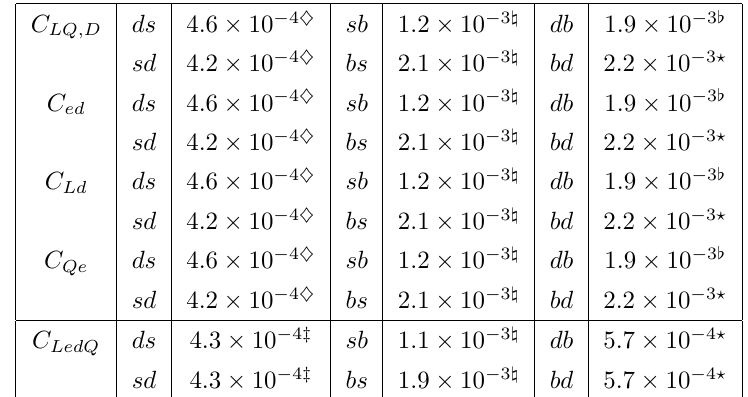
Table 13 . 90% C.L. upper limits on the down-type quark-flavor-violating semileptonic operators, assuming a single operator is turned on at the scale Λ = 1 TeV. The superscripts denote that the limits come from τ decay modes ( ♦ ) τ → eπK or ( ‡ ) τ → eK B d → τe , ( [ ) B + → π + τe or ( \ ) B + → K + τe . The limit on the scalar operators is applicable to both the τe and eτ elements.